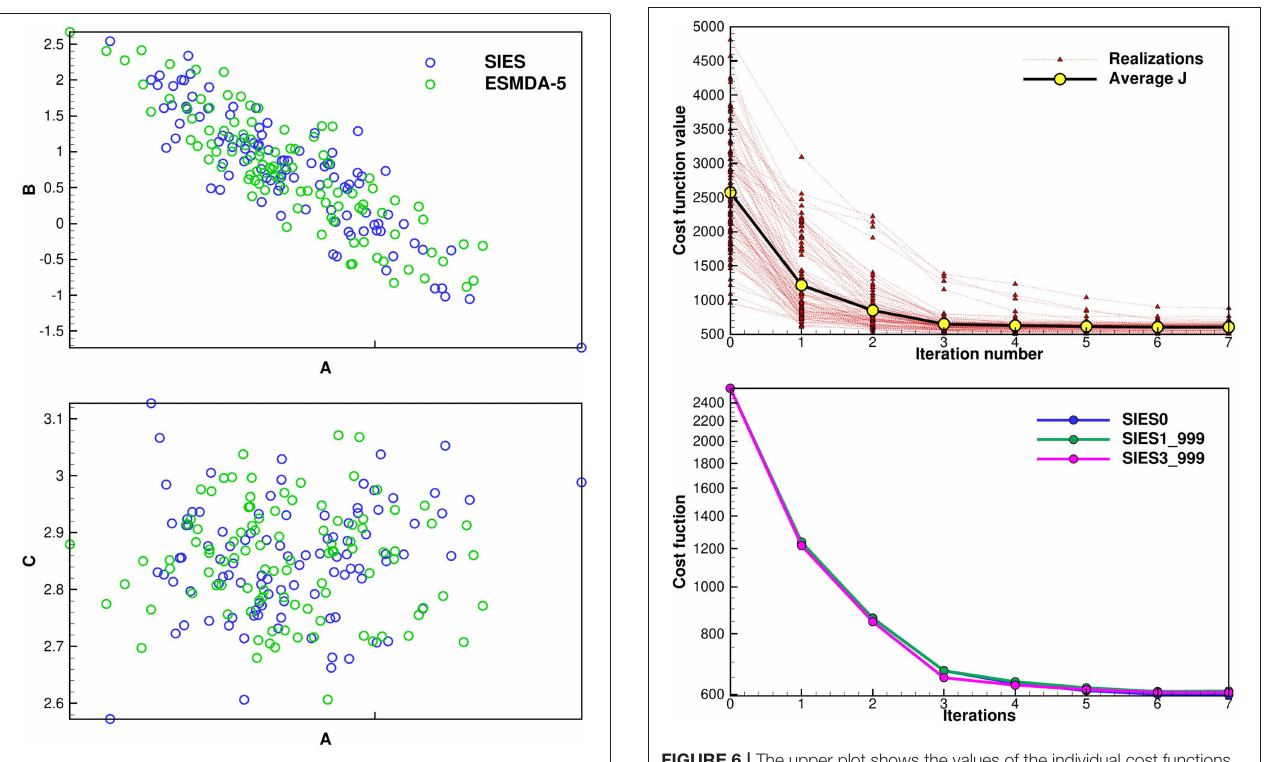
FIGURE 5 | Cross plots of coefficients a , b , and c for the polynomial Gauss-linear case: The solution using ESMDA (here with 5 steps) differs from the SIES for each realization due to resampling of measurement errors in each ESMDA step, but the methods sample the same posterior in the Gauss-linear case.